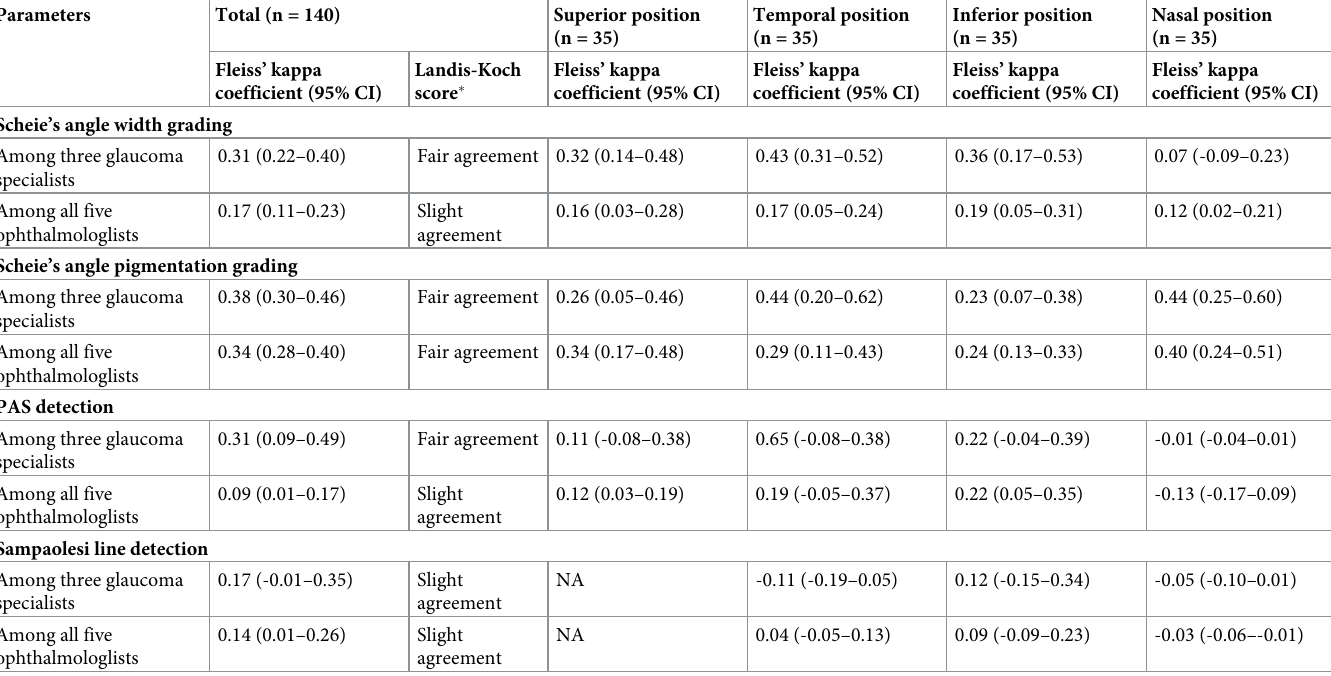
Table 5. Interobserver agreement analyses for angle evaluations using GS-1 gonioscopic photos during the first test.